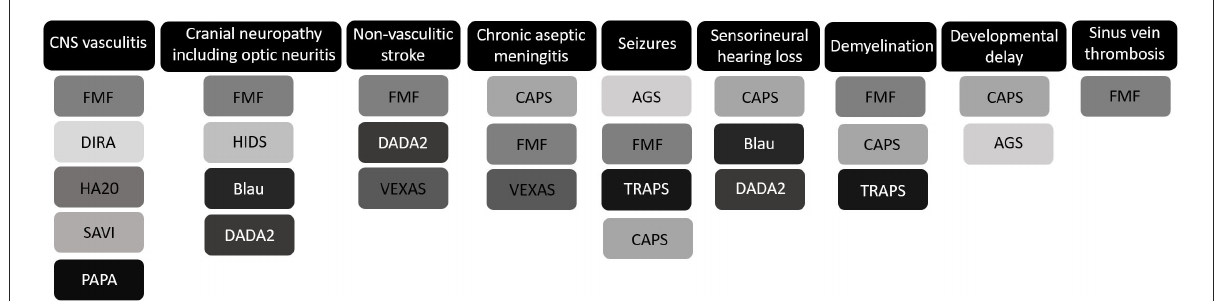
FIGURE1 Graphic overview of the most prominent central nervous system (CNS) manifestations of monogenic autoinflammatory disorders. FMF, familial Mediterranean fever; DIRA, deficiency of IL-1 receptor antagonist; HA20, haploinsufficiency of A20; SAVI, stimulator of interferon genes associated vasculopathy with onset in infancy; PAPA, pyogenic arthritis, pyoderma gangrenosum, and acne syndrome; HIDS, hyperimmunoglobulinemia D syndrome; DADA2, deficiency of adenosine deaminase-2; VEXAS, vacuoles, E1 enzyme, X-linked, autoinflammatory, somatic syndrome; CAPS, cryopyrin-associated periodic syndromes; AGS, Aicardi-Goutières syndrome; TRAPS, tumor necrosis factor receptor-associated periodic